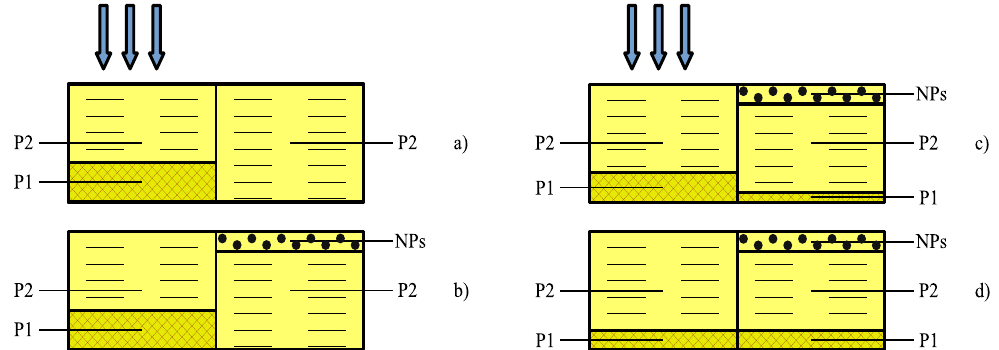
Figure 5. The model under consideration: ( a ) A two-component mixture, without Au NPs; ( b – d ) a three-component mixture containing Au NPs. Table 1. Comparison of theoretical and experimental results for the model in Figure 5.